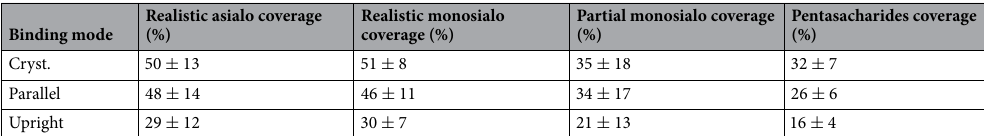
Table 1. Total N-glycan coverage of the residues involved in each binding mode. Data are calculated from systems G1–4 in Table 2. The contributions of each residue to each binding mode are extracted from our previous work 14 . The results indicate how much of the CD44-HABD surface (that is critical to hyaluronate binding) is covered by